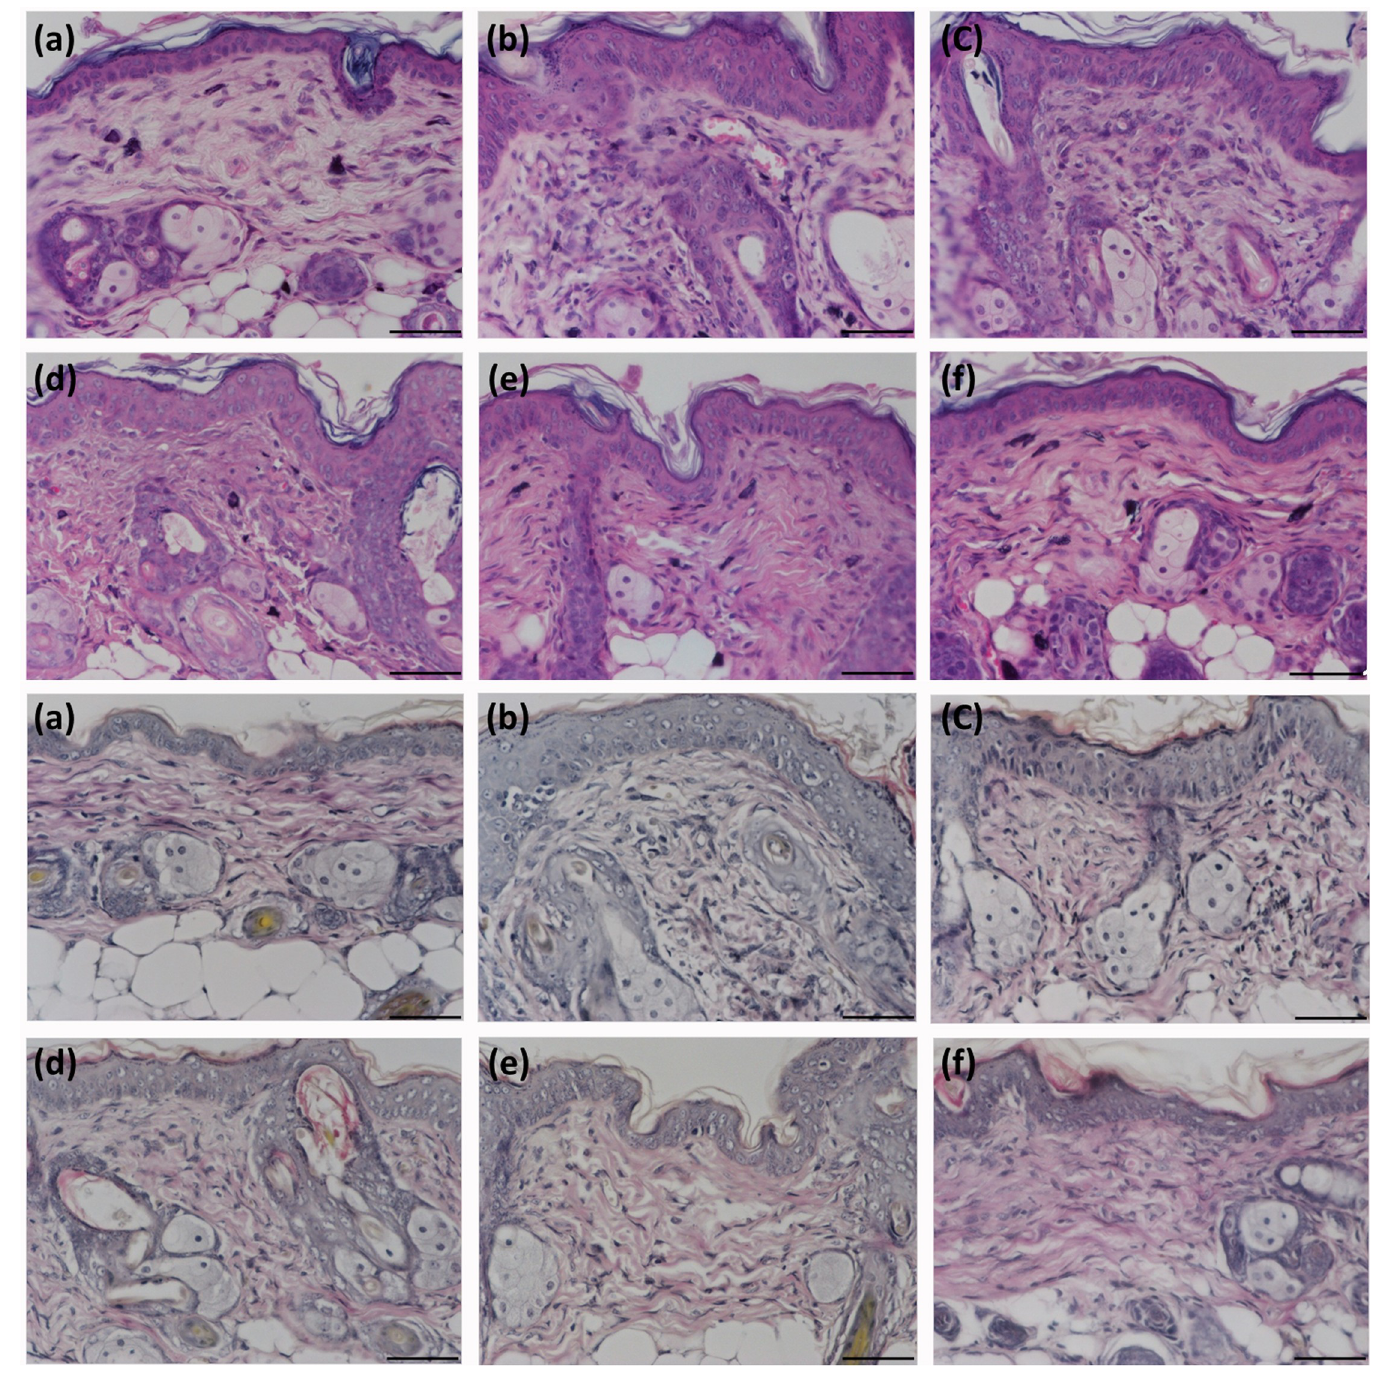
Fig 10. Representative samples showing UV irradiation-induced morphological changes in mouse skin. The upper panel (A) shows hematoxylin and eosin staining, and the lower panel (B) shows modified VVG staining. The sub-panels show samples from a non-exposed normal mouse (a), a UV-irradiated control mouse (b), and UV- irradiated mice treated with Ada (c), US + Ada (d), US + LysMBs + Ada (e), and US + Ada-LysMBs (f). Scale bar = 50 μ m; original magnification 400 × .